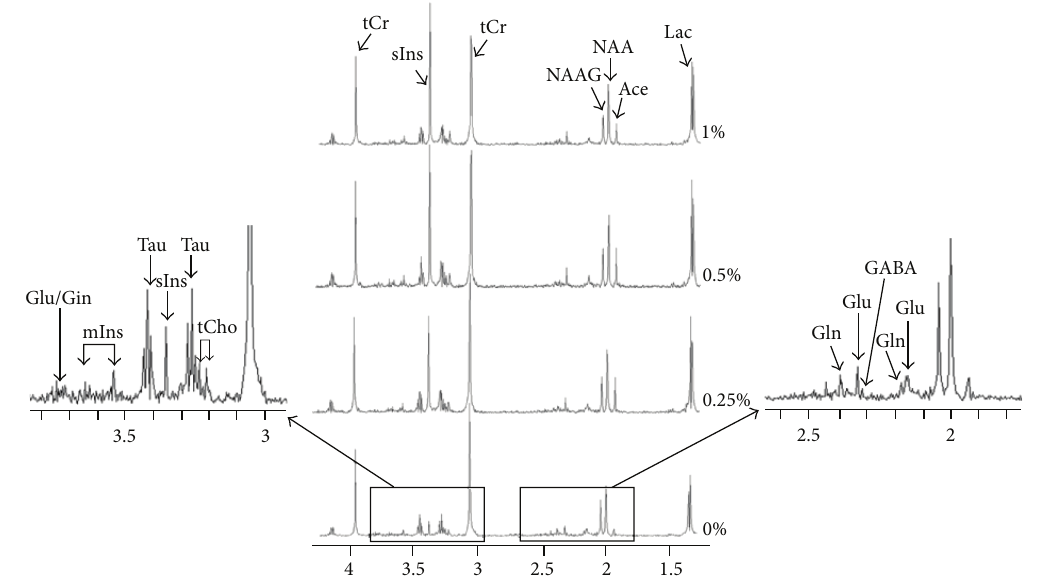
Figure 1: NMR spectra of zebrafish brain in each alcohol concentration group: 12 metabolites (Ace, GABA, Gln, Glu, Lac, mIns, NAA, NAAG, sIns, Tau, tCho, and tCr) were evaluated and quantified.